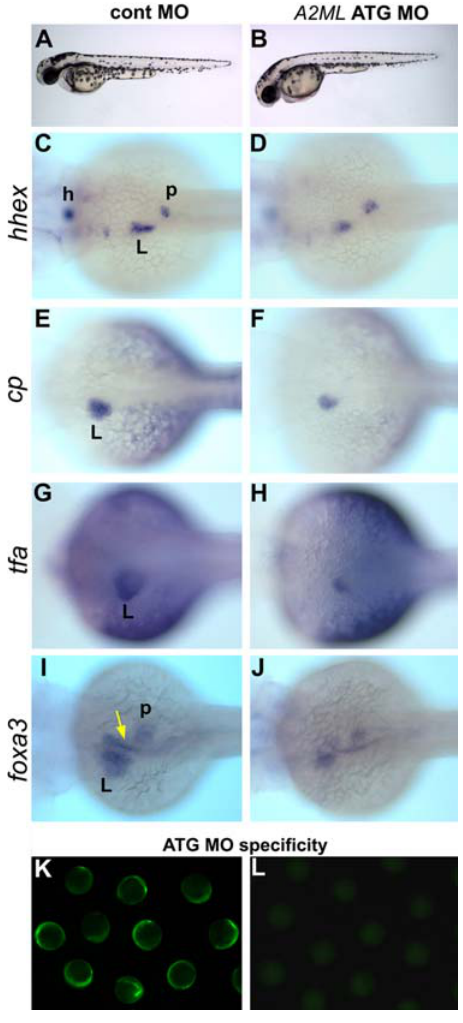
Figure 2. A2ML knock-down phenotype. A2ML ATG MO-injected embryos were at 50 hpf (A–J); embryos in the MO specificity test were at the 3-somite stage (K–L). A–B. Lateral view of live images of control and A2ML ATG MO-injected embryos. C–J. Dorsal views of whole mount in situ hybridization with hhex (C–D), cp (E–F), tfa (G–H), and foxa3 (I–J) of cont MO (C, E, G, I) and A2ML ATG MO (D, F, H, J) injected embryos. A yellow arrow in (I) points to the developing hepatopancre- atic duct. K–L. An A2ML-GFP fusion construct was expressed in 95% ( n =40) of embryos after coinjection with control MO, while coinjection of A2ML ATG MO blocked expression of the fusion construct in 95% ( n = 55) of embryos. h, heart; L, liver; p, pancreatic primodium.